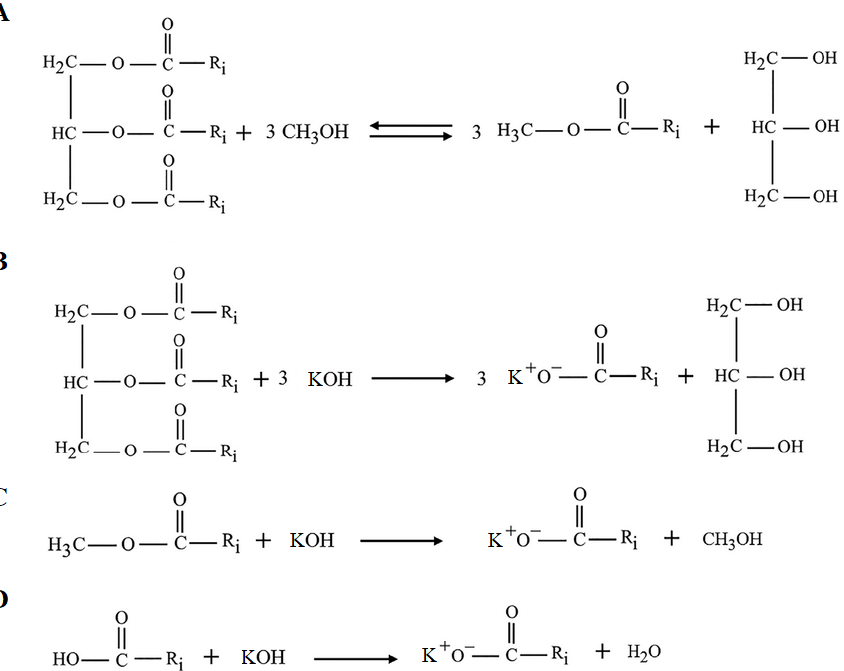
Figure 1. Simplified scheme of the chemical reaction process through alkali catalysed transesterification–transesterification ( A ), saponification of triacylglycerols ( B ), and esters ( C ), and neutralisation of FFA ( D ).